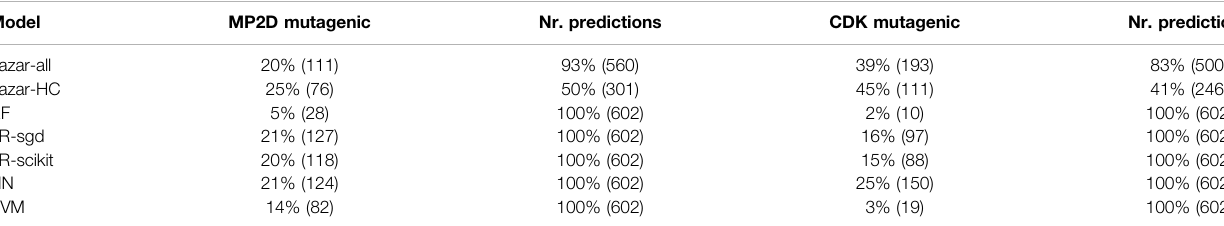
TABLE 3 | Summary of pyrrolizidine alkaloid predictions. Model MP2D mutagenic Nr. predictions CDK mutagenic Nr.